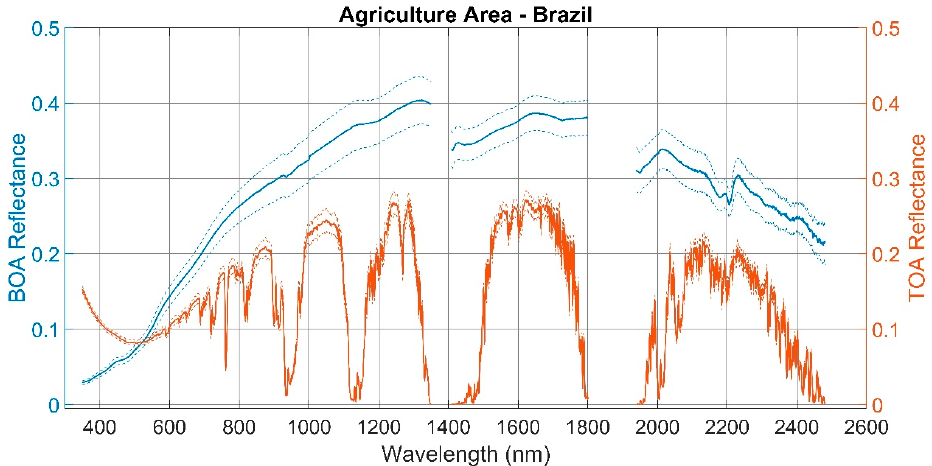
Figure 2. In the y -axis left and right side of the graph is presented, respectively, the BOA and TOA reflectance of Brazil site measured in-situ in July 2014.